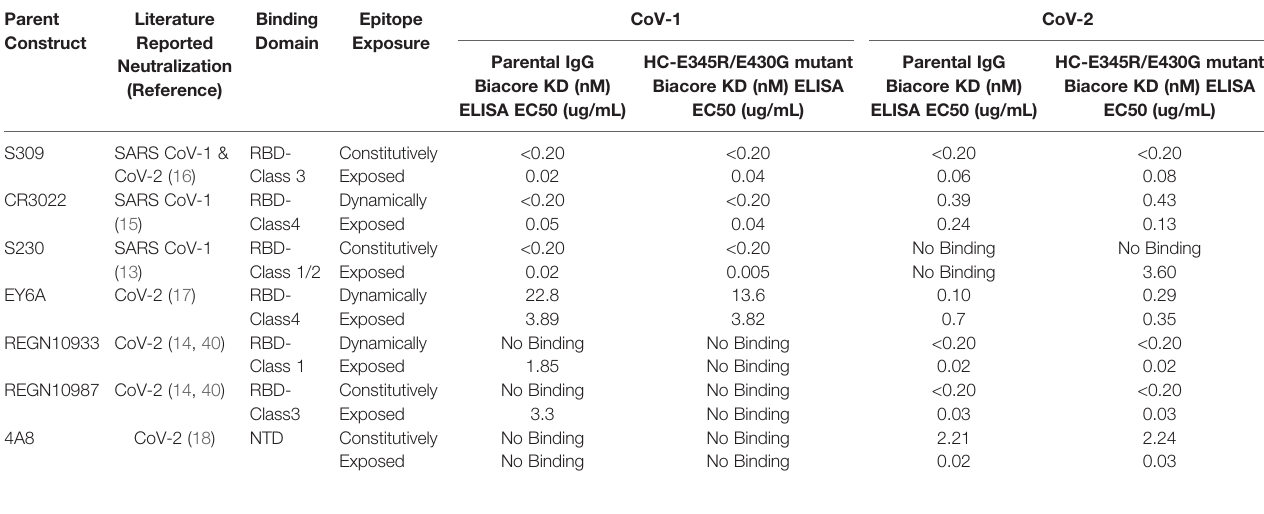
TABLE 1 | Selected antibodies, epitopes, and apparent binding af fi nity to SARS-CoV-1 and SARS-CoV-2 spikes by SPR (top row, Biacore) and ELISA (lower row). Epitope exposure was evaluated in the closed RBD form ( Figure S1b ) and the open RBD form ( Figure S1a ). Epitopes able to bind in either the closed or open form were deemed constitutively exposed, whereas epitopes that become sterically hindered in either the open or closed from were deemed to be dynamically exposed. Parent